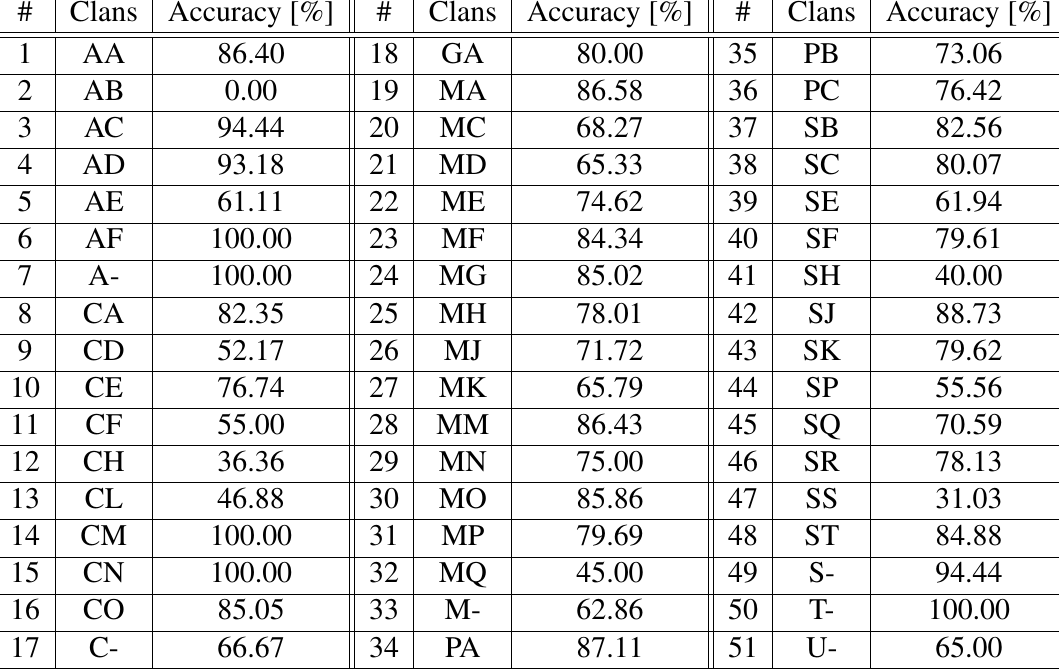
Table 5: Accuracy values for the SVM system by clans.